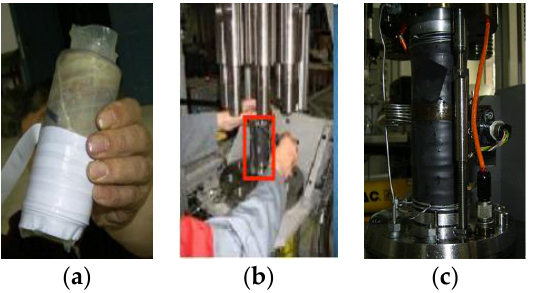
Figure 2. Experimental system and specimen installation. ( a ) Air exhaust. ( b ) Entering the loading room. ( c ) Installation specimen.